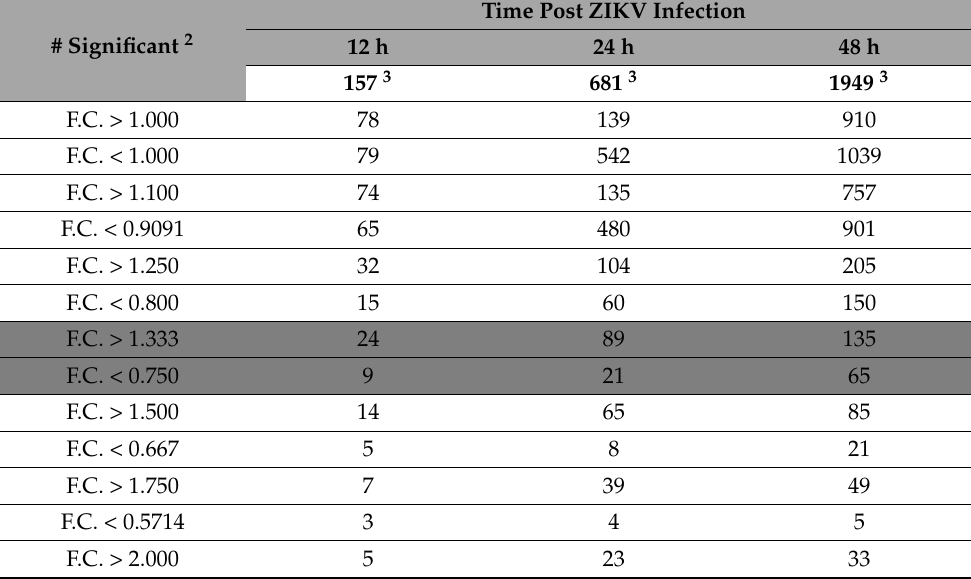
Table 1. Number of significantly dysregulated proteins 1 in ZIKV-infected U251